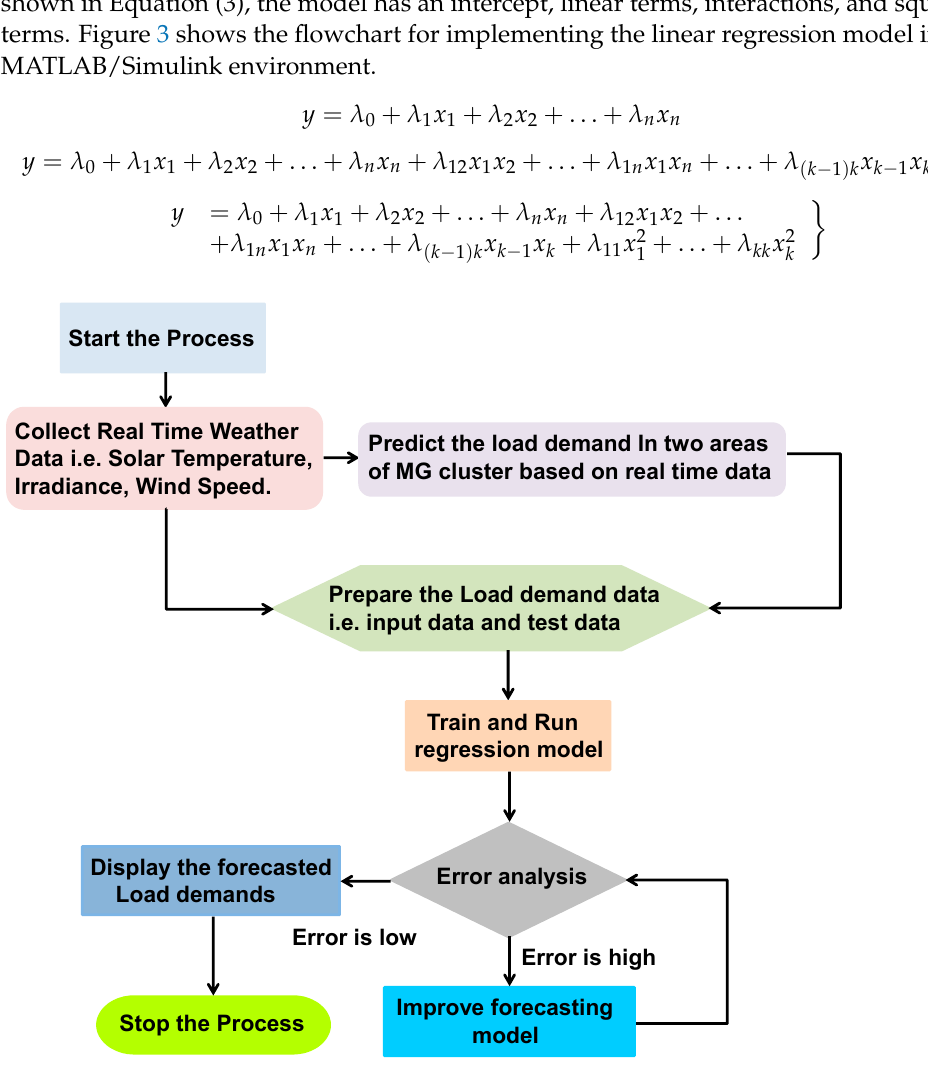
Figure 3. Flowchart for implementing linear regression (quadratic) method.